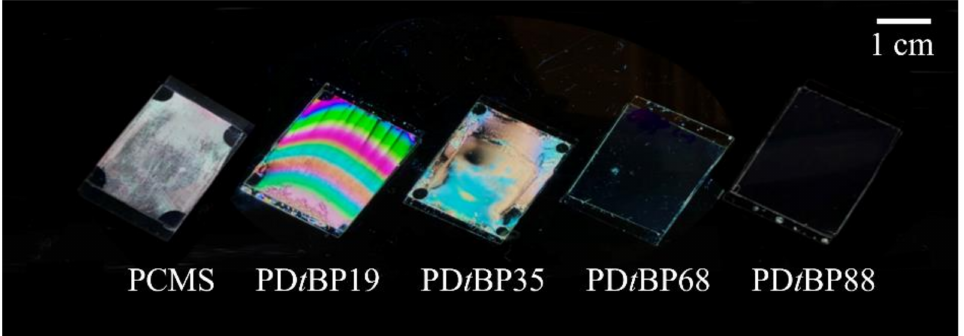
Figure 5. Photograph images of the LC cells made from PD t BP# films according to the molar content of 2,4-di- tert -butylphenoxymethyl moiety.